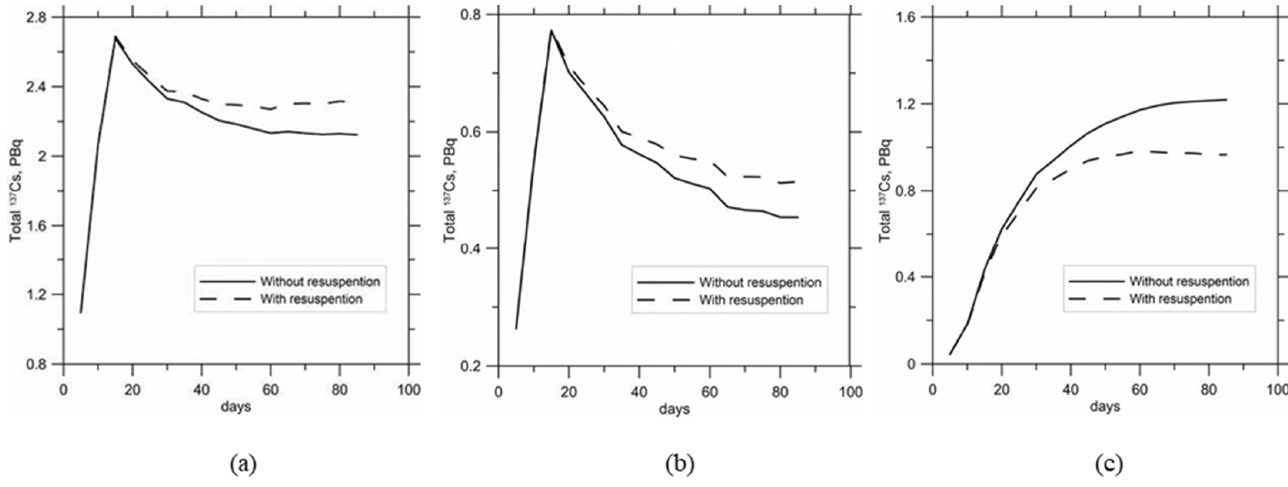
Figure 12. ( a ) Total amount of dissolved 137 Cs after release from the Sanmen NPP; ( b ) total amount of 137 Cs adsorbed on suspended sediments after release from the Sanmen NPP; ( c ) total amount of bottom contamination of 137 Cs after beginning of release from the Sanmen NPP.